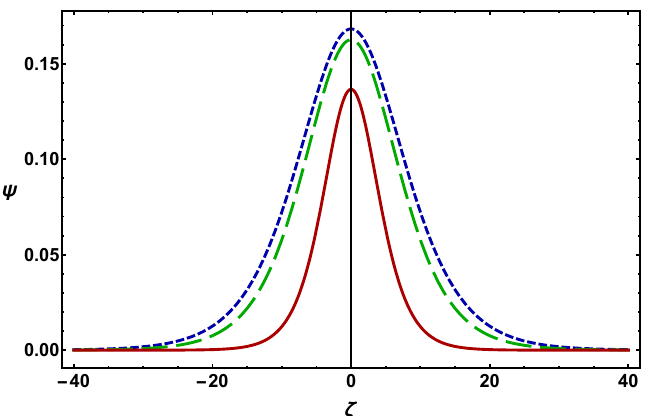
Figure 3. The effect of temperature on NA wave potential ψ in degenerate non-relativistic plasmas by considering σ Te = 0 (blue dotted curve), σ Te = 0.1 (green dashed curve), and σ Te = 0.2 (red solid curve) when θ = 5 ◦ , Ω c = 0.05, Ω 0 = 0.03, l x = 0.2, σ e = 10, and δ = 0.3.